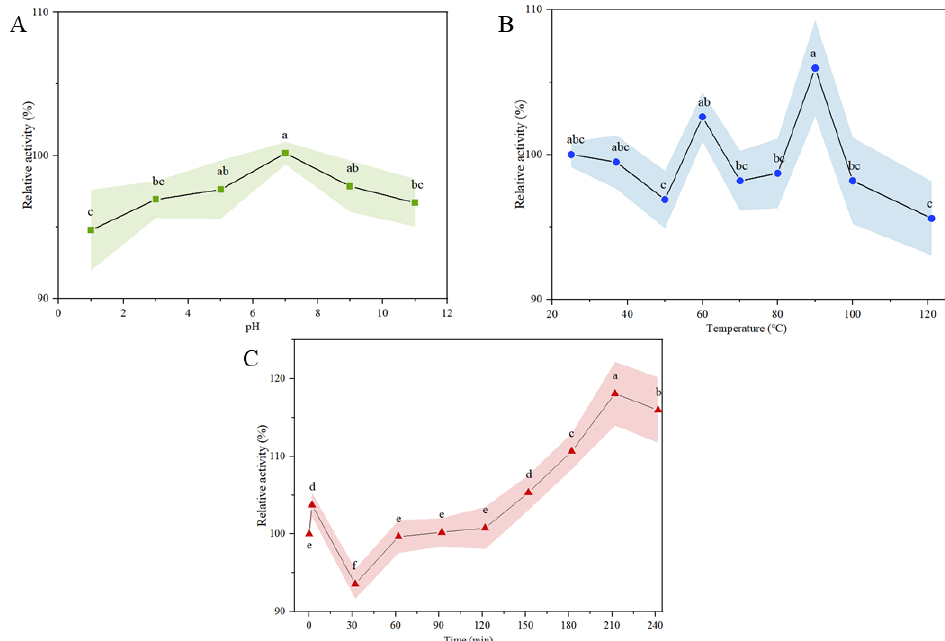
Figure 5. α -glucosidase inhibitory stability of PMHs against pH ( A ), hot ( B ), and in vitro gastroin- testinal ( C ) with oral, gastric, and intestinal phases. Different letters indicate significant differences ( p <